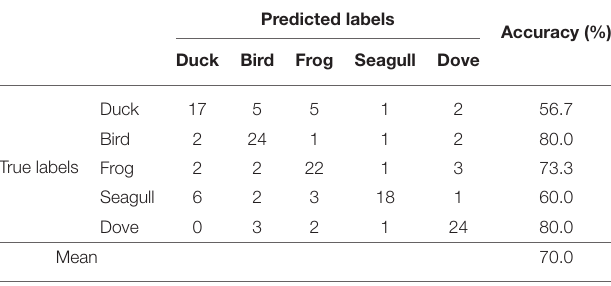
TABLE 2 | Confusion matrix of five sound labels over all subjects in offline